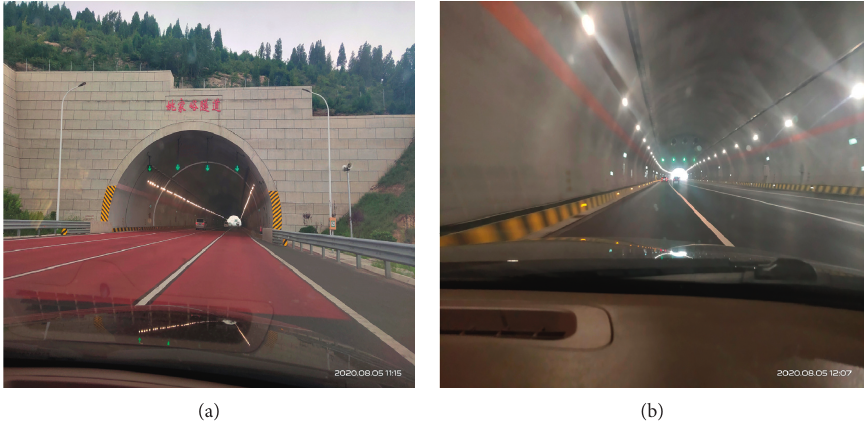
Figure 2: Experimental scene: (a) entrance of tunnel, (b) inside of